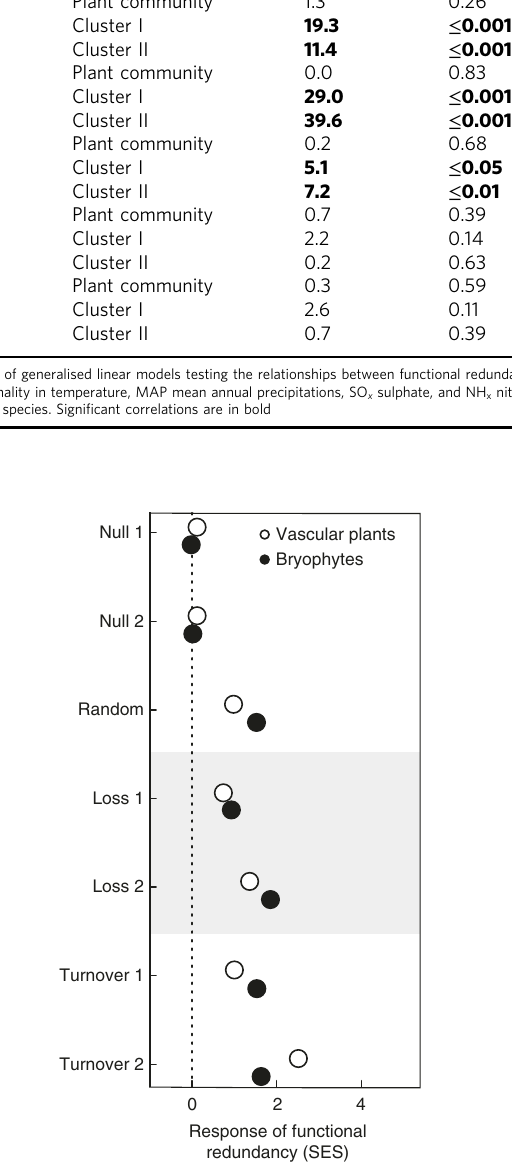
Plant community